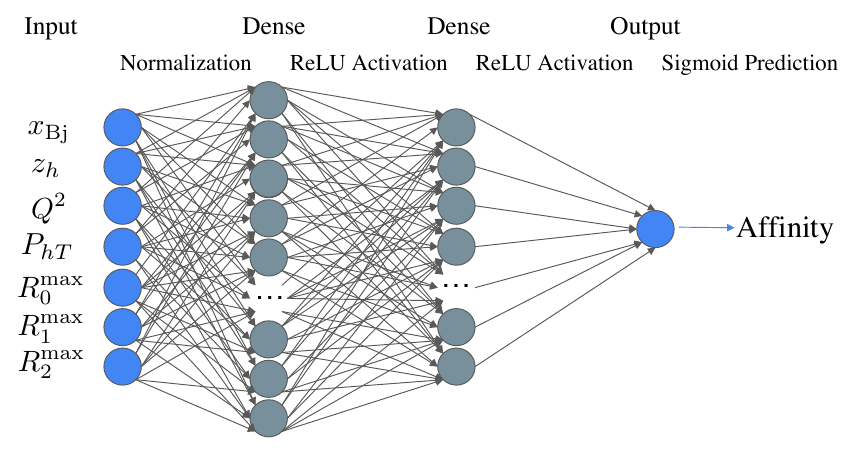
Figure 16 . Schematic illustration of the architecture of the neural network devised for calculating affinity. Each arrow represents a trainable parameter that each neural network must learn through training. Input, hidden layers, and output are represented by the (stack of) blobs. The normaliza- tion layer and ReLU activation functions are necessary to mitigate the vanishing gradient